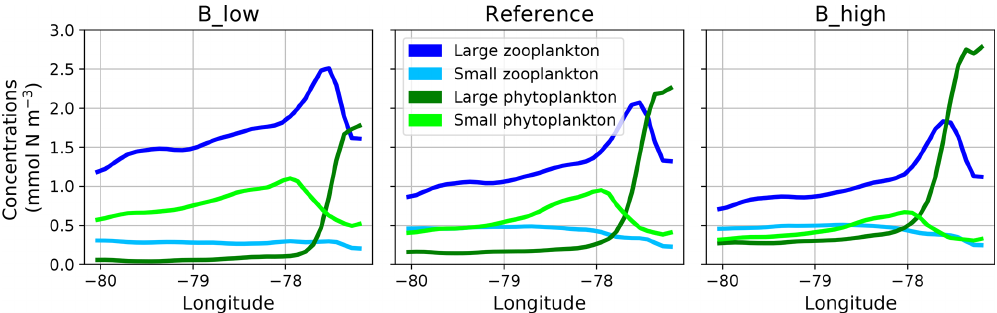
Figure 5. Zonal distribution of surface plankton concentrations at 12 ◦ S annually averaged in the reference and the two B scenarios, respec- tively. The location of this section is indicated as a white line in Fig.